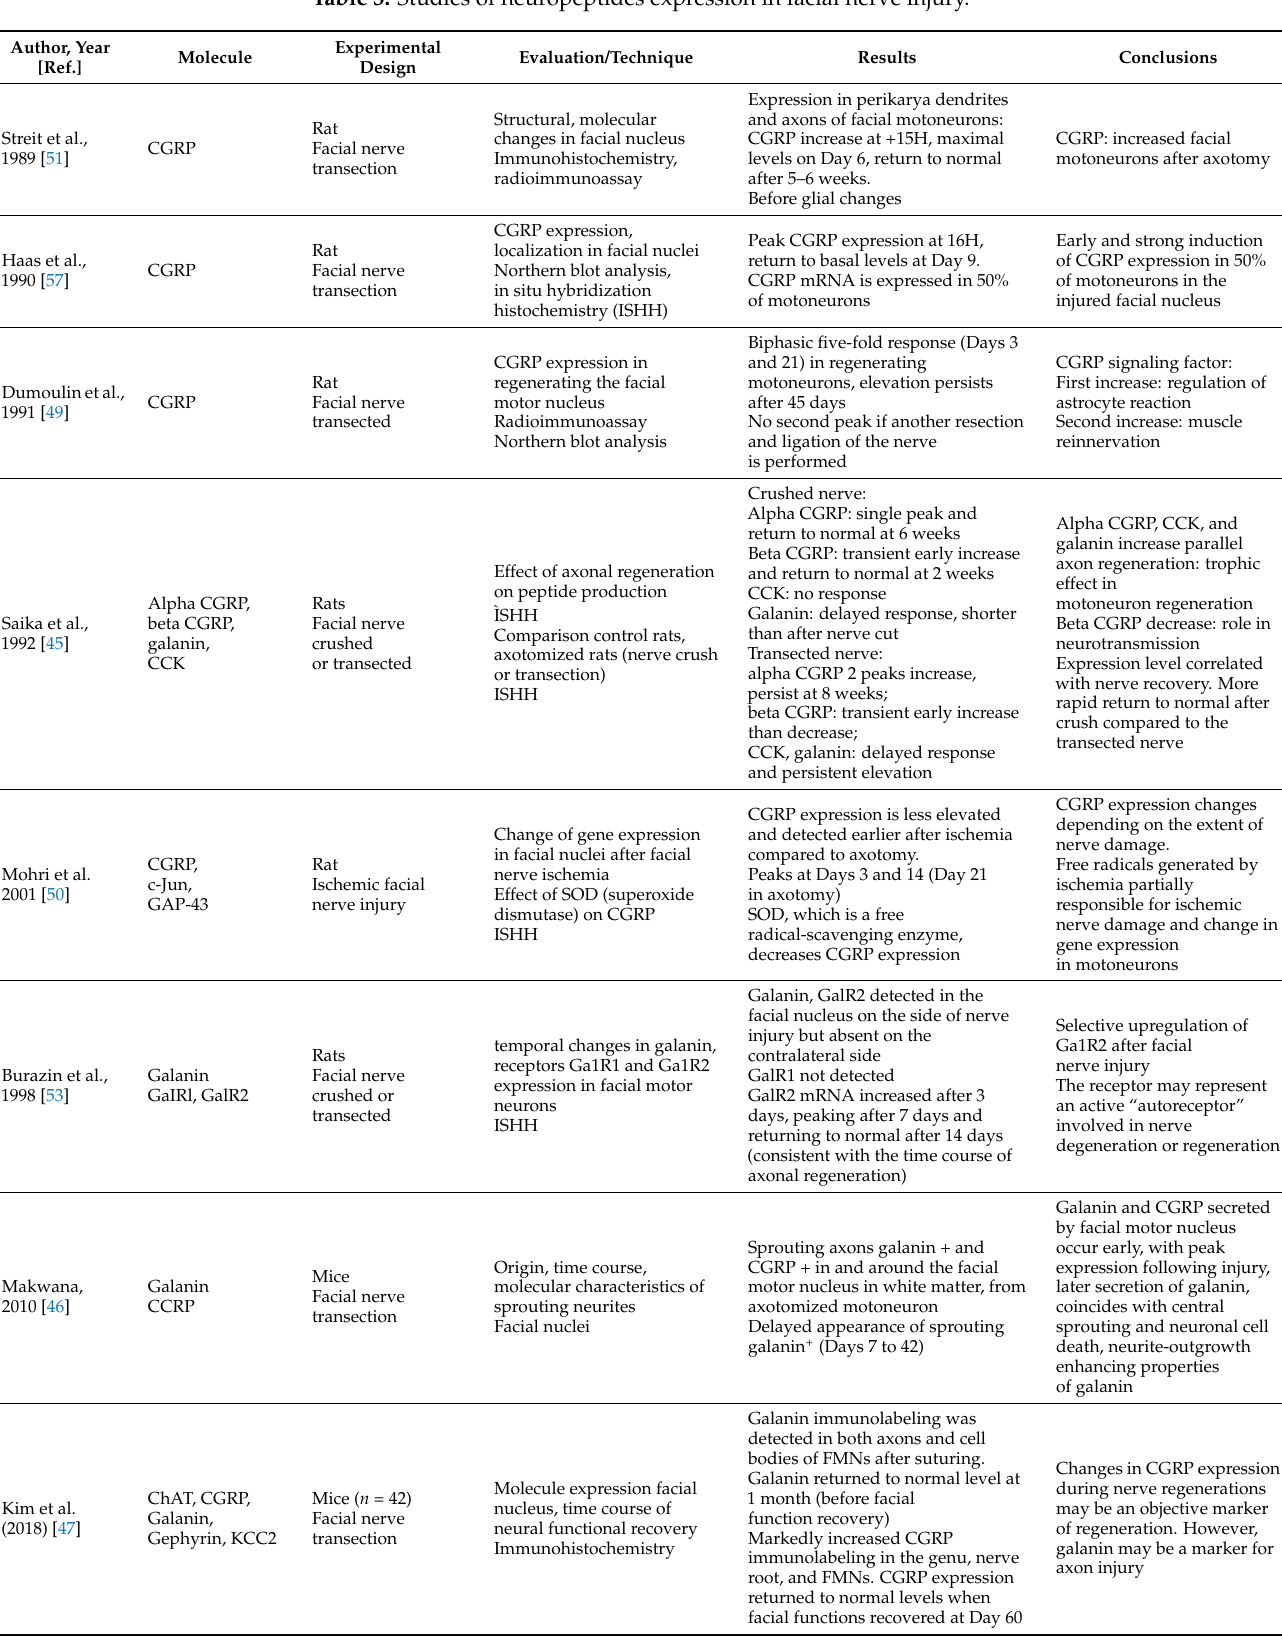
Table 3. Studies of neuropeptides expression in facial nerve